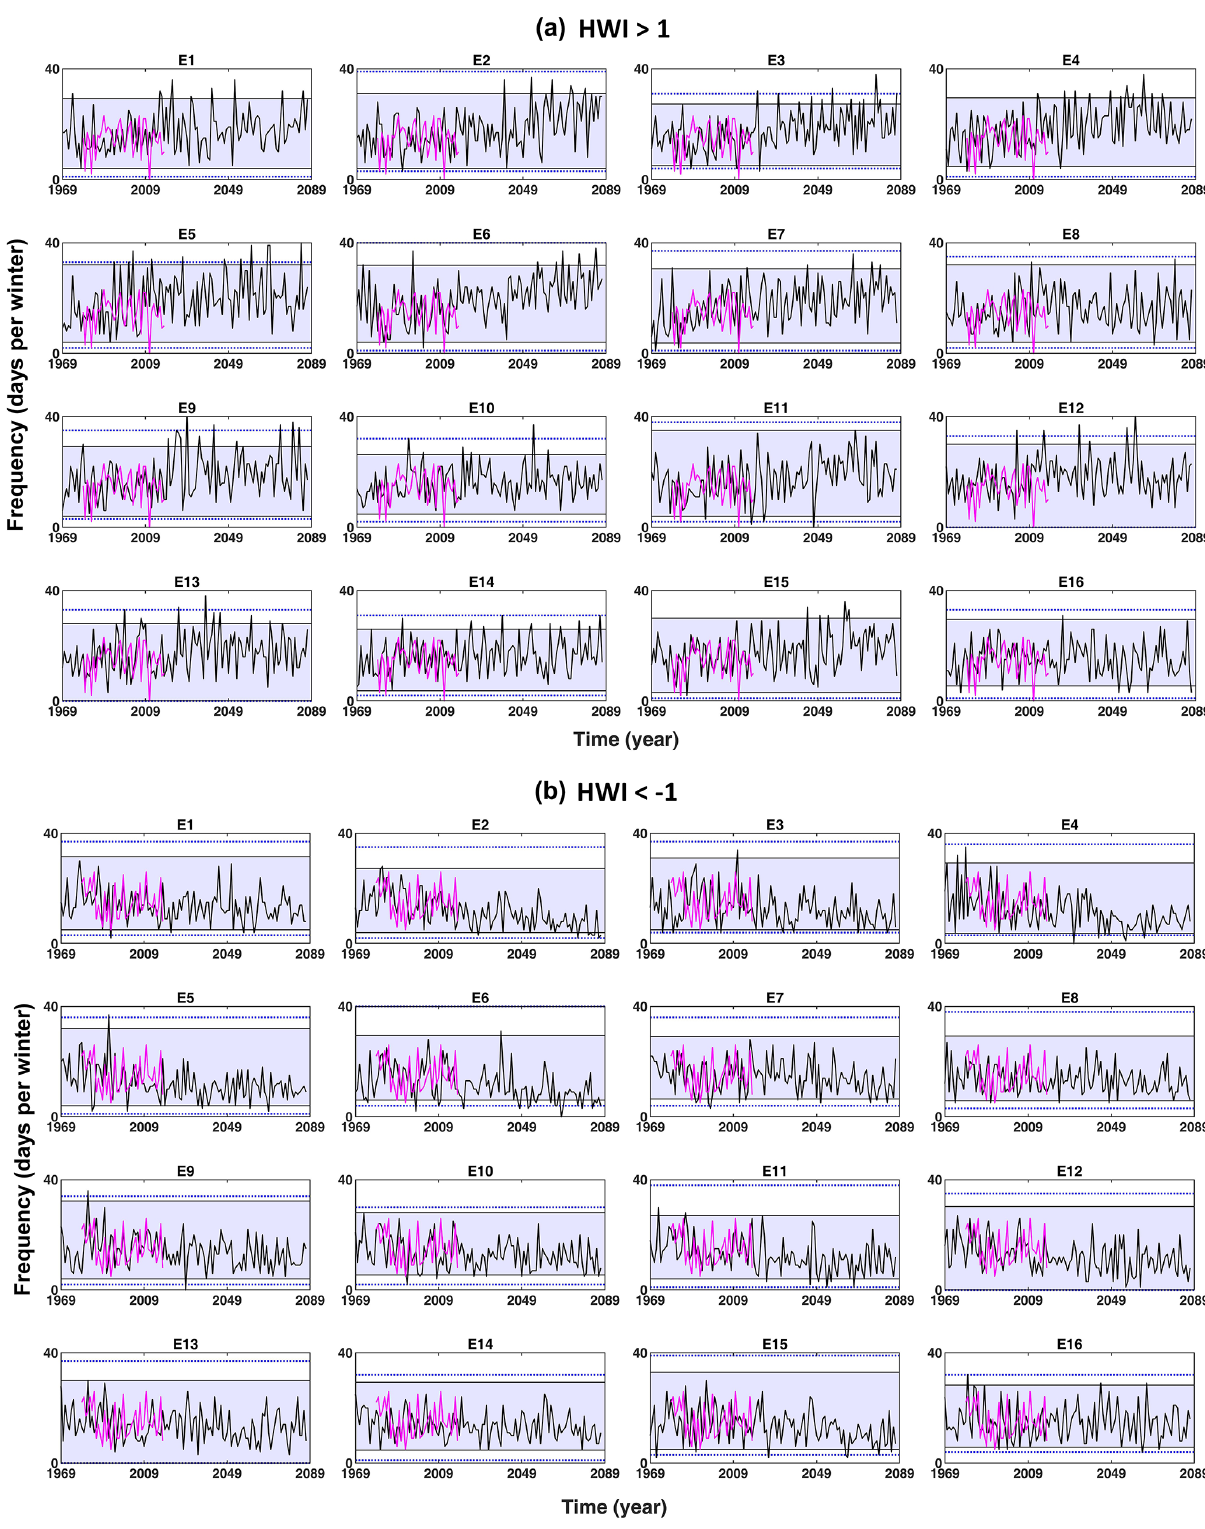
Figure 10. Frequency of (a) haze-conducive weather (HWI > 1) and (b) clear weather (HWI < − 1) per winter for individual PPE members (black line) under the historical and RCP8.5 scenarios for 1969–2087 and the ERA-5 reanalysis (pink line) for 1979–2018. The blue-shaded regions show the 95th confidence intervals and the dotted blue lines shows the ranges of haze-conducive and clear weather frequency for the pre-industrial control simulation of 170